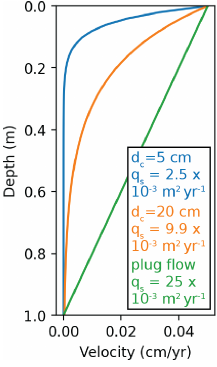
Figure 8. Representative velocity profiles of solifluction and asso- ciated volumetric sediment fluxes ( q s ) for an active layer of thick- ness 1m, such as observed at the Teller 47 site. For exponentially decaying profiles as observed in sites compiled by Glade et al. (2021), the depth at which V ( h ) = 0 varies between 20 and 80cm. For plug flow, modeled off the observations of Lewkowicz and Clarke (1998), velocity decays linearly with depth and thus repre- sents higher volumetric sediment